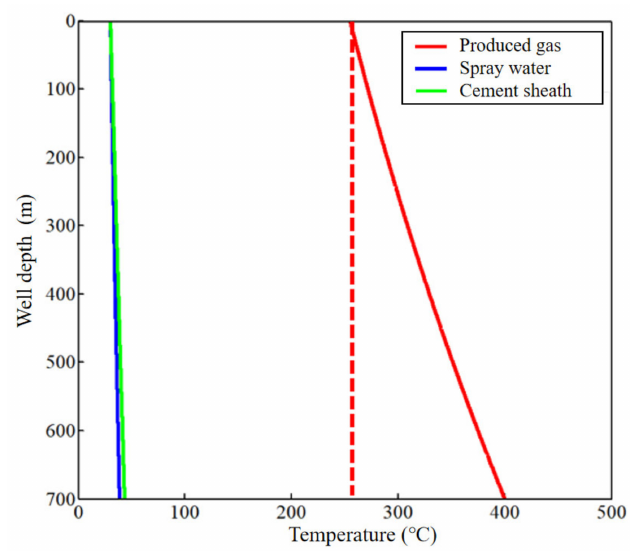
Figure 9. Temperature distribution of annulus water injection wellbore.